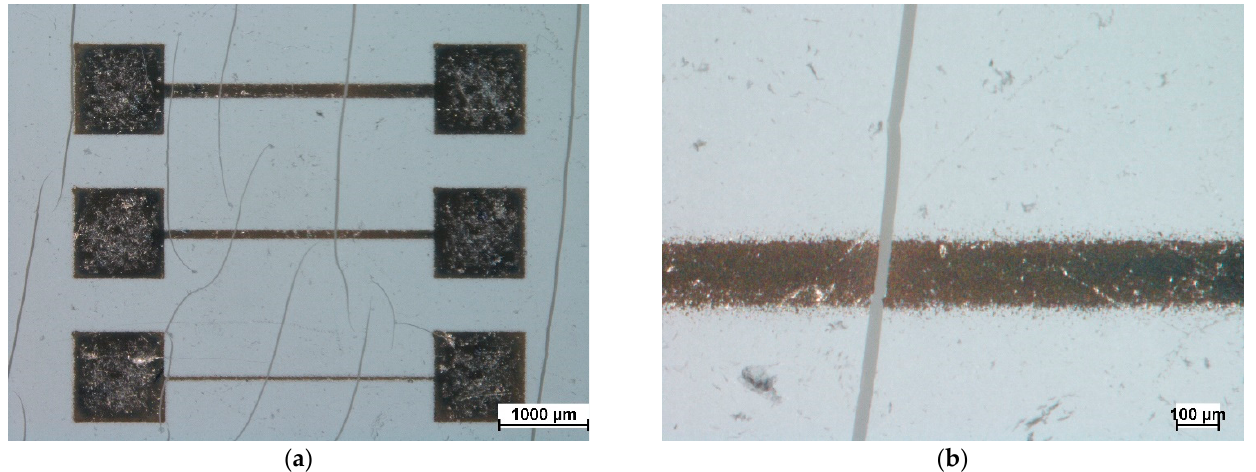
Figure 13. Cracks in ear mold substrate after reflow soldering with 180 °C peak temperature ( a ). Close-in view of crack through conductor path ( b ).